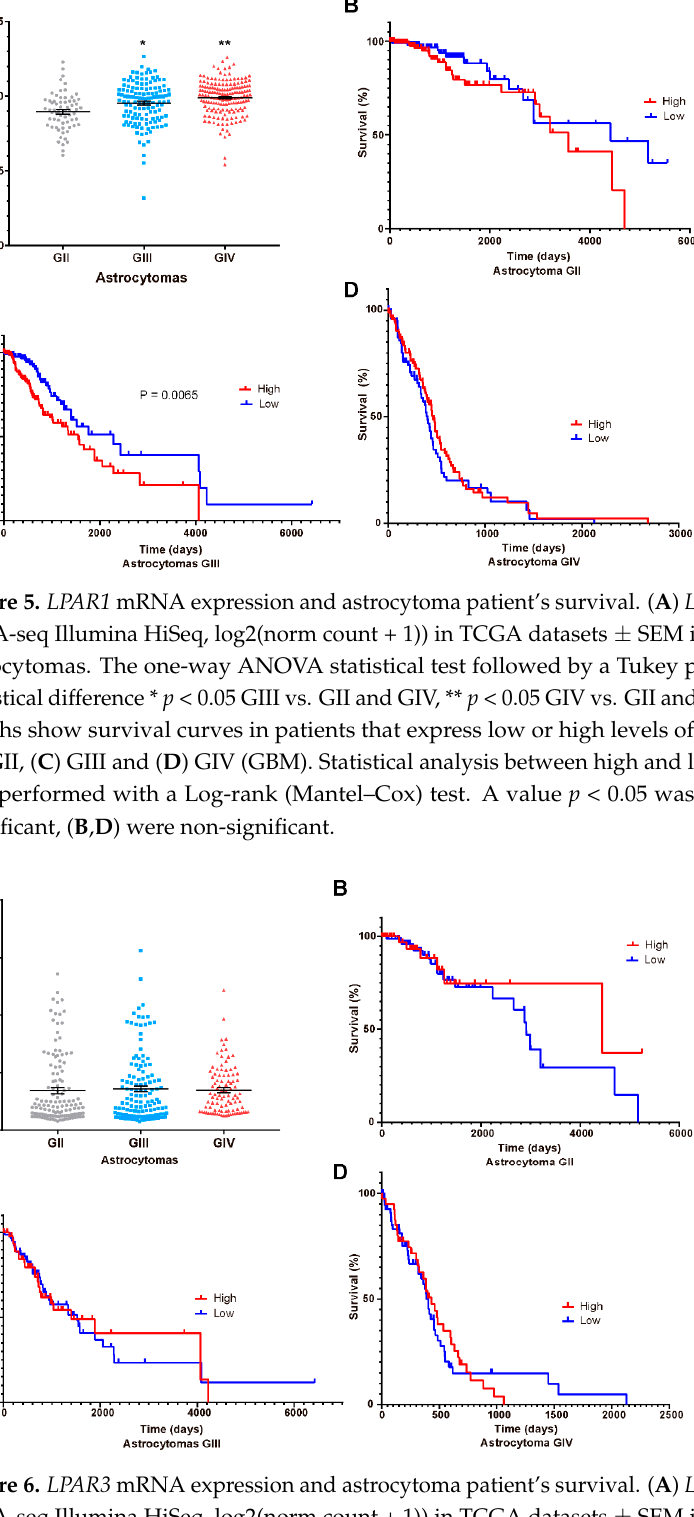
Figure 7. ENPP2 mRNA expression and astrocytoma patient’s survival. ( A ) ENPP2 mRNA expres- sion (RNA-seq Illumina HiSeq, log2(norm count + 1)) in TCGA datasets ± SEM in different grades